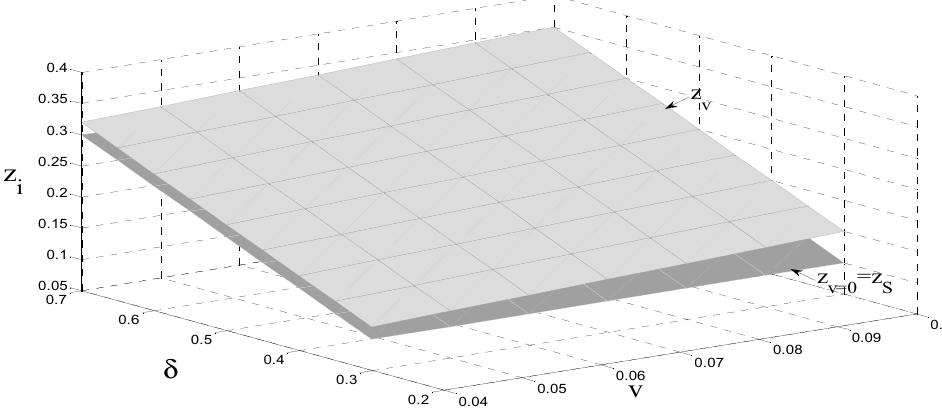
Figure 2. The relationship between the subsidy, consumer preference, and the authorization